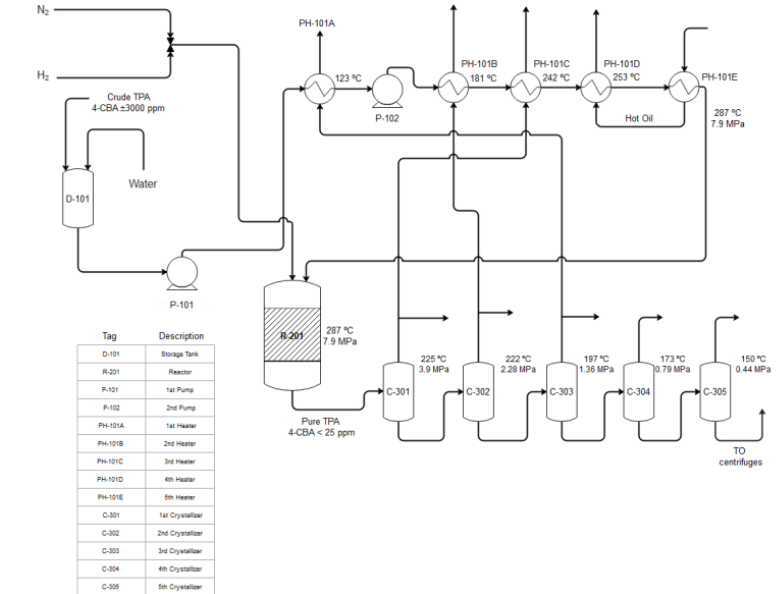
Figure 10. Flow sheet of an industrial hydropurification plant for TPA. Adapted from [68].